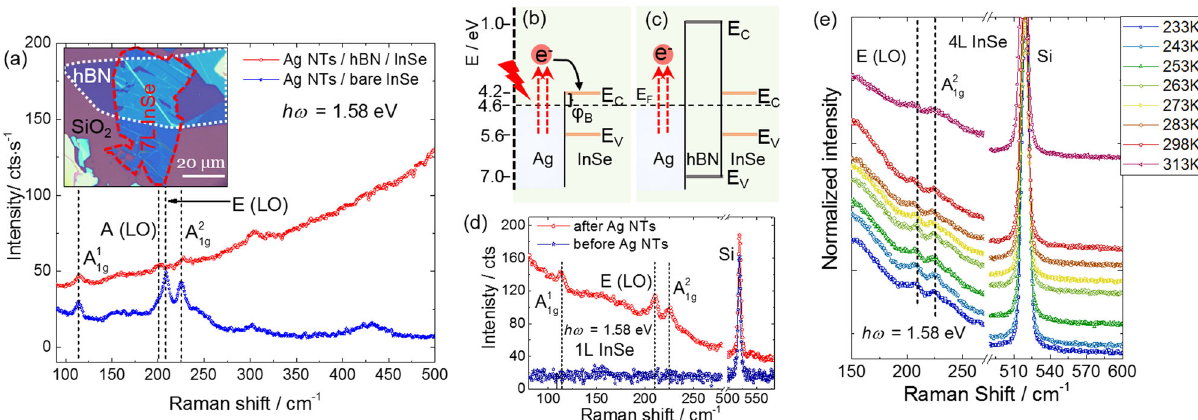
Fig. 3 Effect of charge carriers and bandgap on Fröhlich interaction in InSe. a Raman spectra taken with 1.58 eV excitation of hBN encapsulated and bare InSe/Ag NTs demonstrating the in fl uence of plasmonic hot electron doping. The inset is the optical image of the partially encapsulated sample used for the measurements. The areas marked by the white dotted and red dashed lines indicate hBN and InSe, respectively. b , c Simpli fi ed diagram of the band alignment illustrating the hot electron injection process. b InSe with Ag nanotriangles (NTs), c InSe/hBN/Ag NTs. The values are taken from the refs. 13, 40, 41 . d Raman spectra of monolayer (1 L) InSe before and after Ag NTs deposition. The bandgap of 1 L InSe is well above the excitation energy at 1.58 eV. e Temperature-dependent Raman measurements of 4 L InSe/Ag NTs at 1.58 eV excitation. The acquisition parameters of the Raman measurements are 30 s × 2 (7 L) and 150 s × 2 (1 L), 10 μ W under ×100, 0.9 NA objective. The acquisition parameters for the temperature-dependent Raman measurements were 150 s × 2, 10 μ W under ×50, 0.45 NA